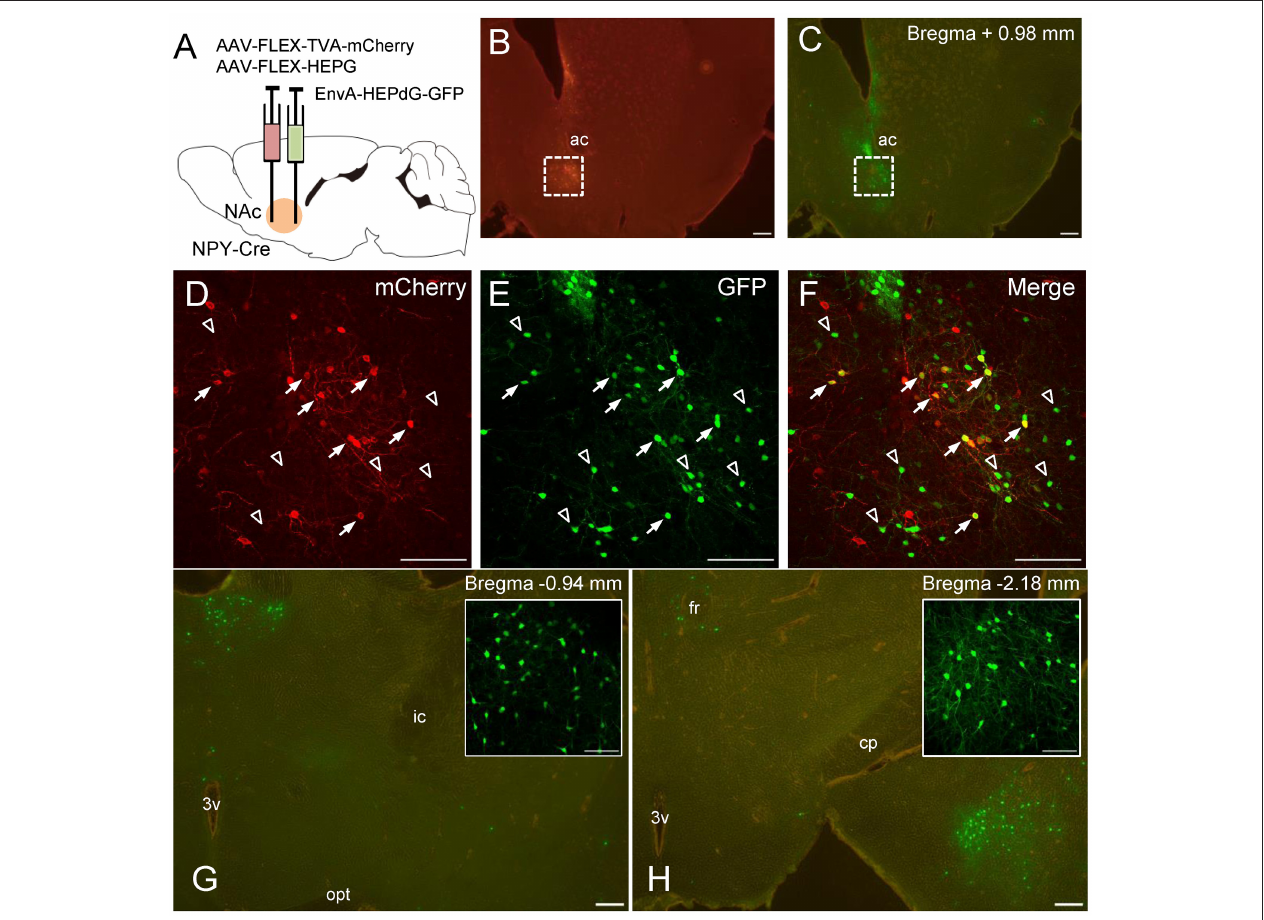
FIGURE 6 | Schematic illustration of AAV(dj)-FLEX-TVA-mCherry, AAV(dj)-FLEX-SADcvsG, and EnvA-HEPdG-GFP injection into the NAc in NPY-Cre mice (A) . Representative photographs of AAV(dj)-FLEX-TVA-mCherry (B) and EnvA-HEPdG-GFP (C) injection sites. Fluorescence image of mCherry (D) , GFP (E) , and merged (F ) in the NAc. Arrows show mCherry and GFP double-positive neurons, representing first-infected NPY neurons in the NAc. Open arrowhead shows GFP-positive/mCherry-negative neurons, which are neurons projecting to accumbal NPY neurons. GFP-positive neurons were also found mainly in the midline thalamic nuclei (G) and the pBMA (H) . Boxed regions in G and H indicate the midline thalamic nucleus and the pBMA, respectively. Scale bars, 100 or 50 µ m (inset). Numerical values in each photomicrographs show distances from bregma (mm). ac, anterior commissure; cp, cerebral peduncle; fr, fasciculus retroflexus; ic, internal capsule; opt, optic tract; 3v, third